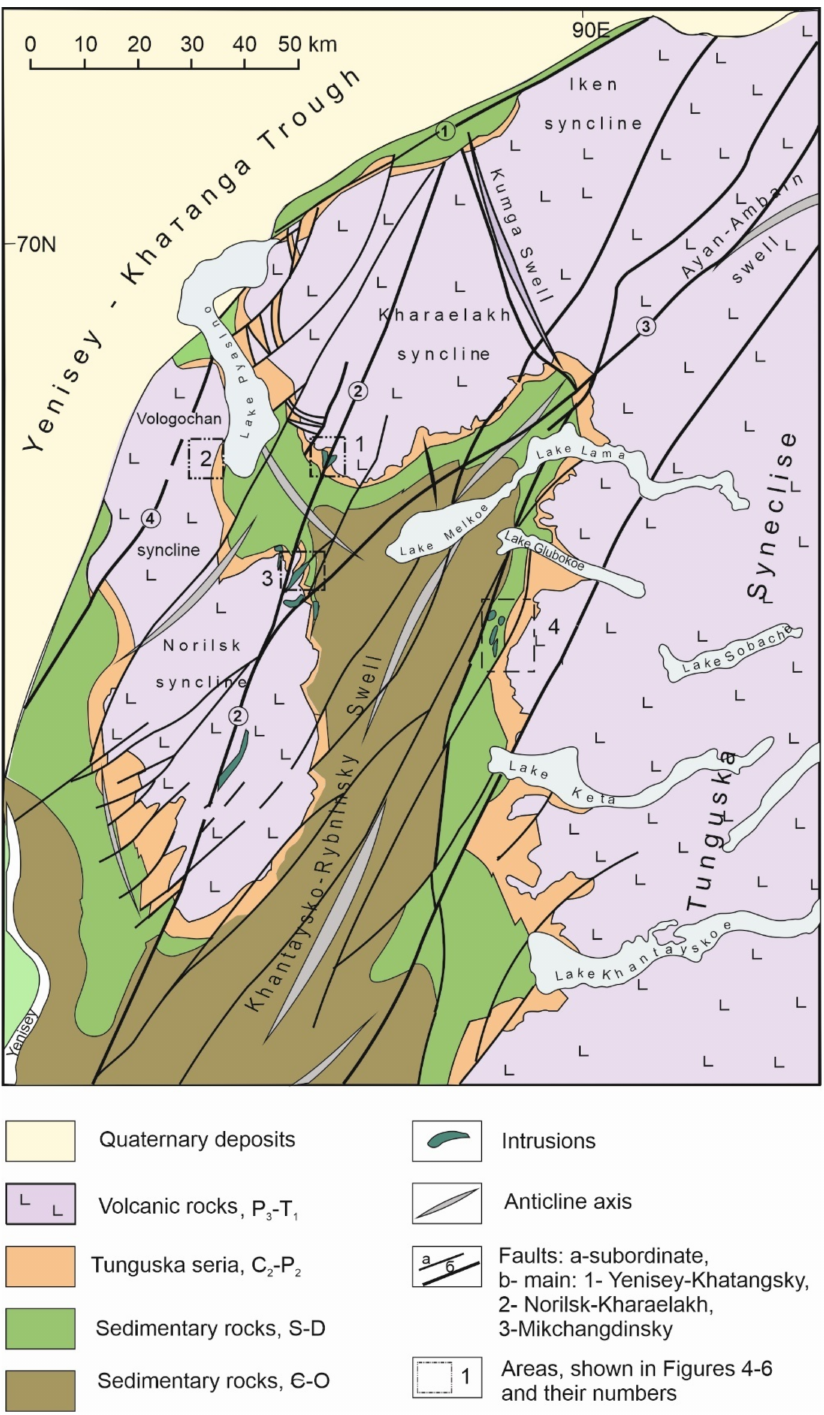
Figure 2. Schematic geologic map of the Norilsk area (after [37], with the authors’ correc- tions). Faults numbers: 1—Yenisey-Khatangsky, 2—Norilsk-Kharaelakhsky, 3—Mikchangdinsky,